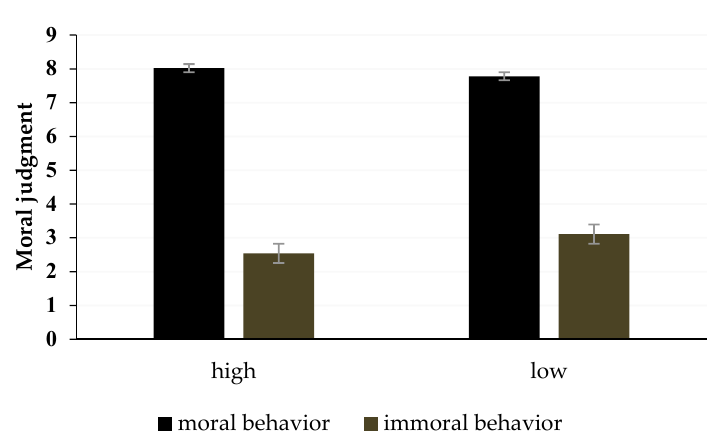
Figure 7. The interaction effect between environmental style and behavioral style on moral judg- ment.